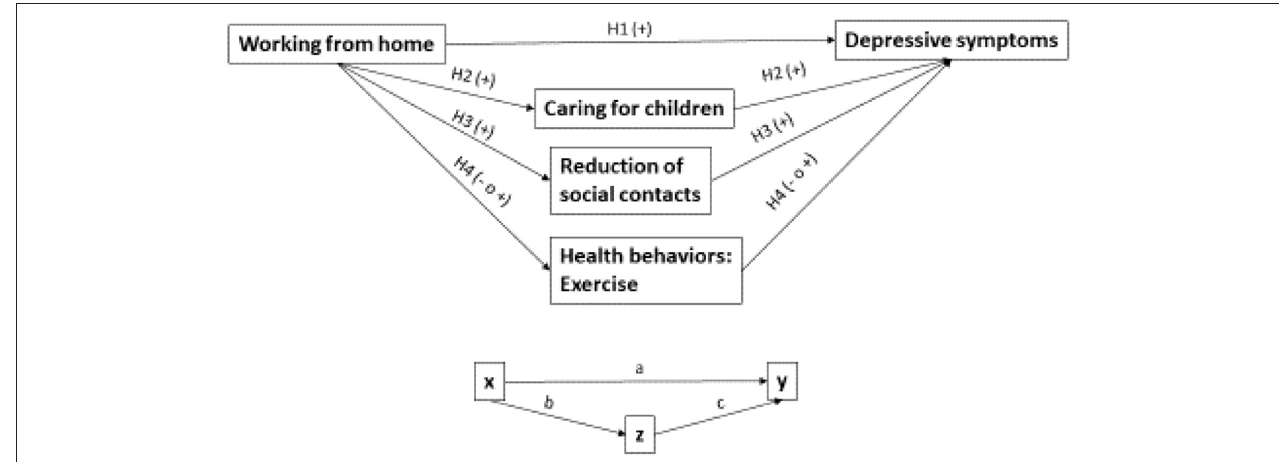
FIGURE 1 | Causal model for mediation